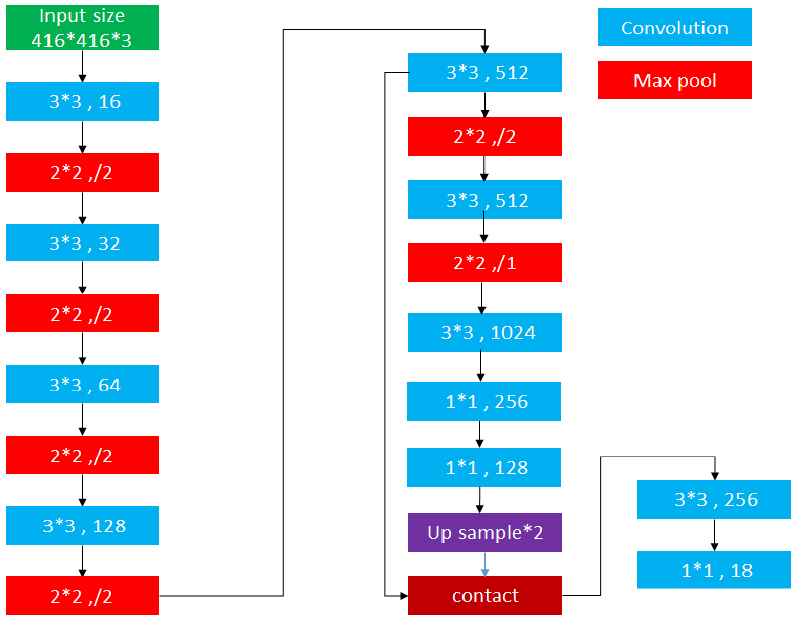
Figure 9. The network architecture of the YOLOv3-tiny model with one anchor and a one-way path.